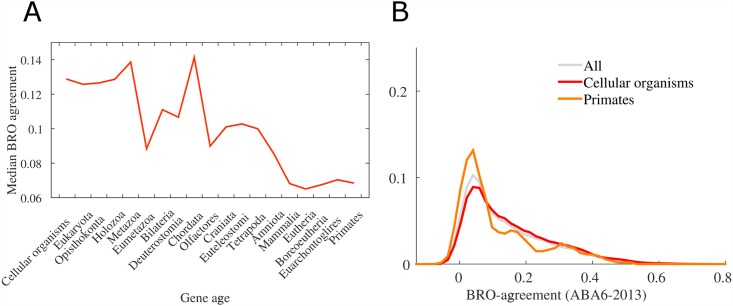
Evolutionary-older genes have on average higher BRO-scores.(A) The median BRO score as a function of the evolutionary age of genes. Older genes receive on average higher BRO scores than evolutionary recent genes. (B) Focus on the distribution of BRO scores for the oldest gene group and of the most recent (primates) gene group. Genes in the cellular organisim group have a median BRO-score of 0.129, while genes in the primate group have a median BRO-score of 0.068. The two distributions are signifatcly different.(Wilcoxonon two-tail test: p-value = 10−6).